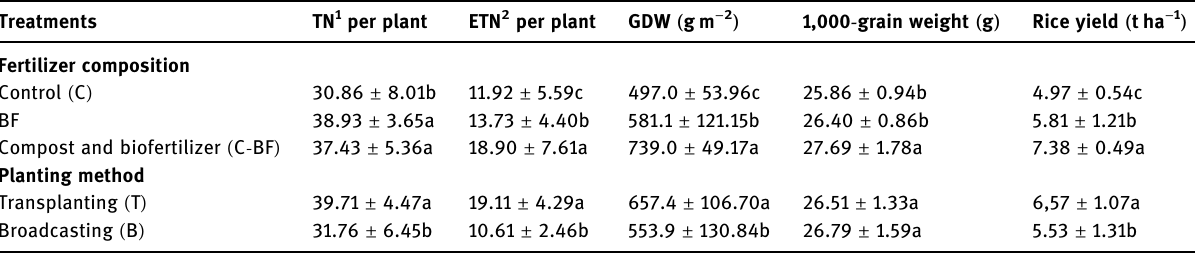
Table 4: Main e ff ect of fertilizer combination and planting method on yield parameters